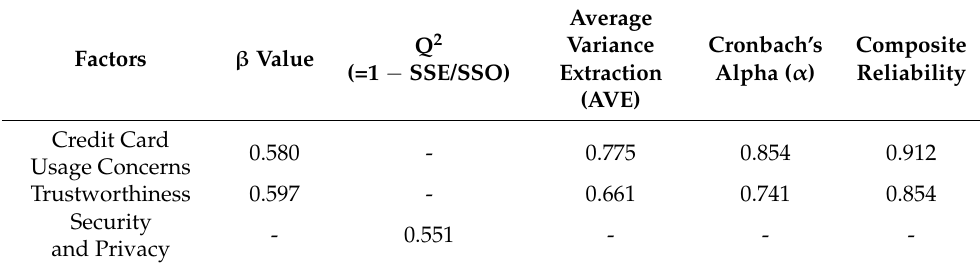
Table 3. Predictive relevance of model factors for